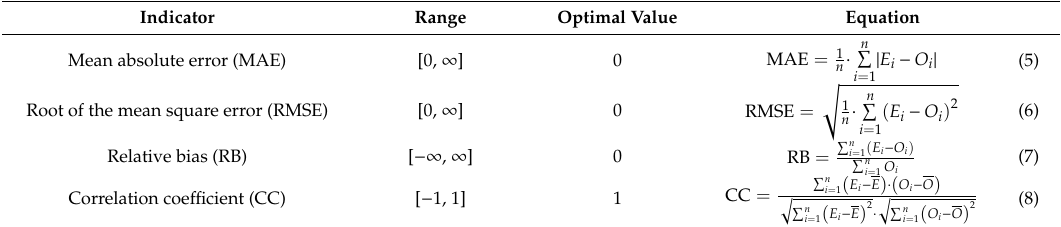
Table 4. Indicators for the quantification of the precision or discrepancy between the CMORPH estimates and the precipitation data of the rain